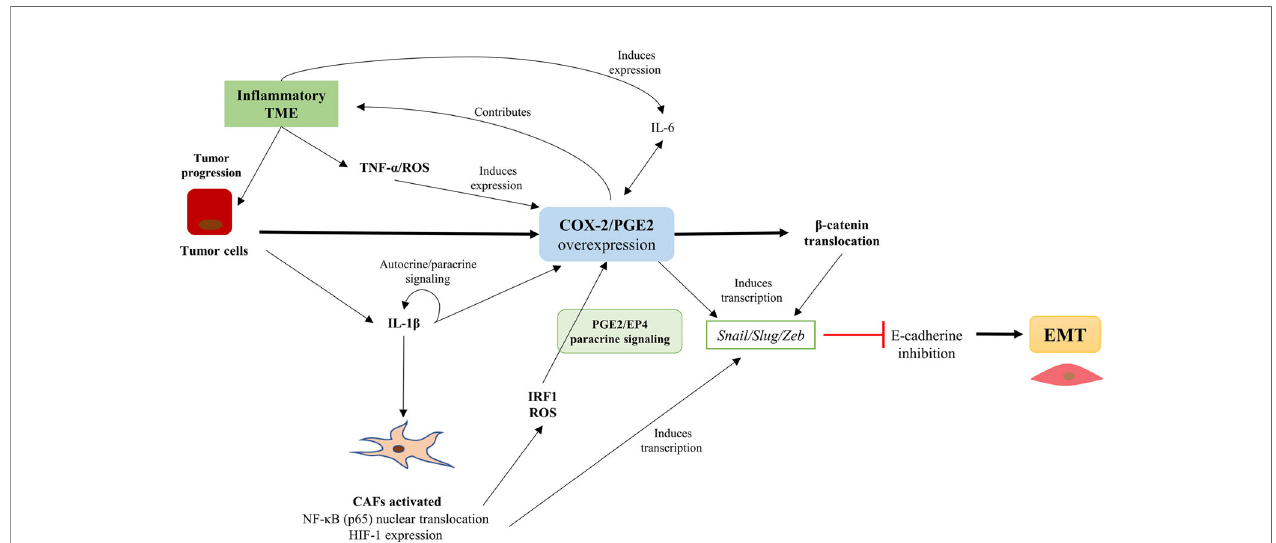
FIGURE 3 | The COX-2/PGE2 axis overexpression is associated with EMT promotion in tumor cells and the presence of cancer-associated fi broblasts (CAFs) in the tumor microenvironment (TME). The COX-2/PGE2 axis overexpression is associated with EMT promotion in cancer cells and the presence of CAFs in the TME. The in fl ammatory pro fi le of the TME favors the overexpression of the COX-2/PGE2 axis and promotes CAFs activation, which maintain the COX-2/PGE2 axis over- activation. Also, the COX-2/PGE2 axis causing nuclear translocation of b -catenin and the induction of Snail/Slug/Zeb transcription factors expression that repress the E-cadherin and promotes